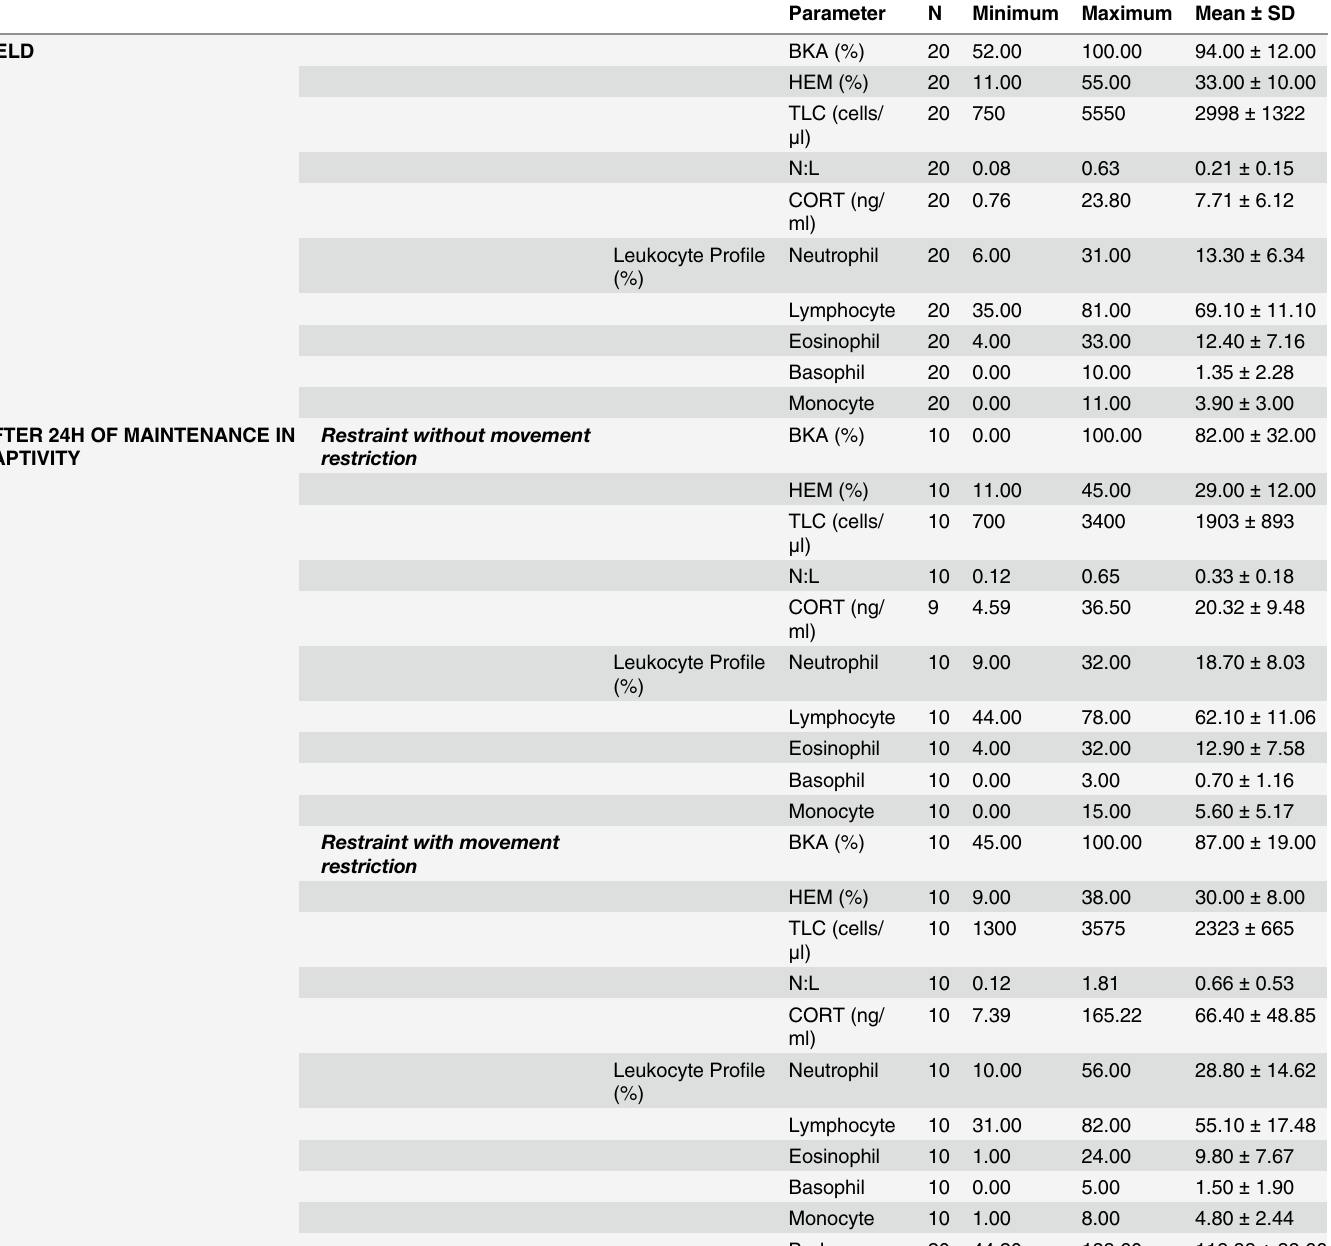
Table 3. Descriptive statistics of blood parameters and body mass for individuals of R . icterica under field conditions and after restraint challenge with and without movement